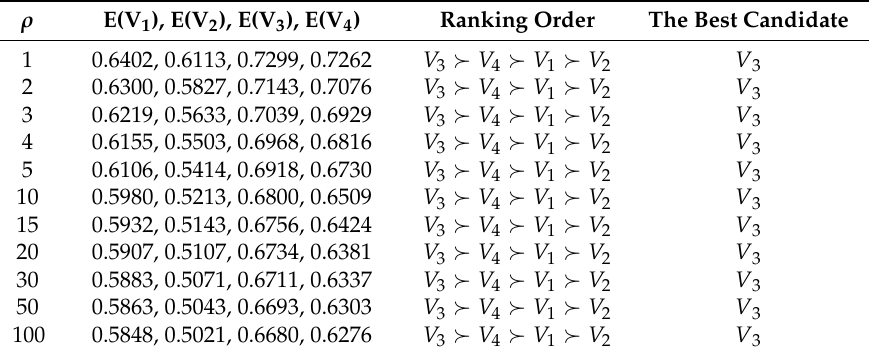
Table 2. Ranking orders of the LCVDWGA 1 operator, ρ ∈